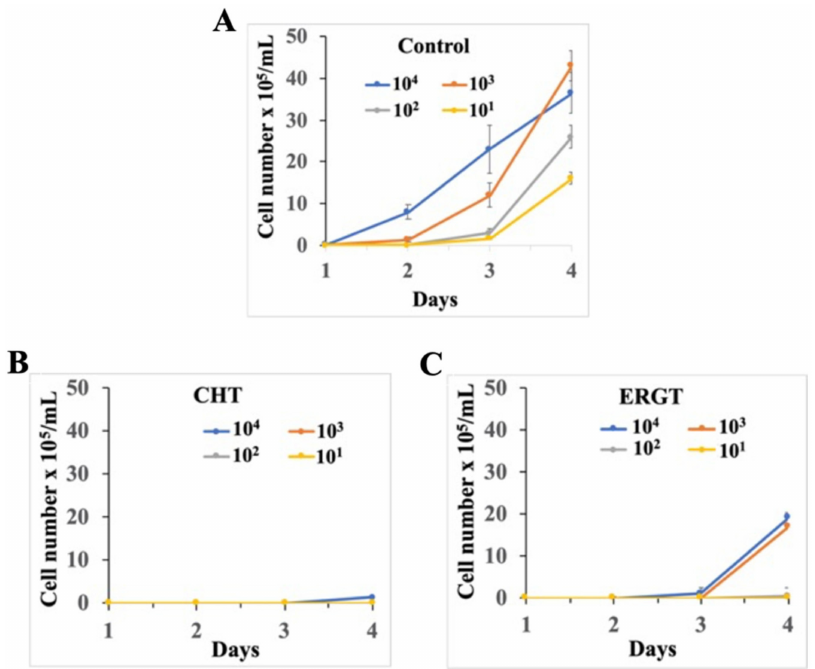
Figure 5. Extended effect of CHT and ERGT on T. brucei BF cell growth. The BF cells were pretreated with CHT and EREGT at 5 × EC 50 concentrations for 2 h. Cells were harvested, washed to remove drugs and reinoculated in fresh medium at different cell numbers (10 4 /mL, 10 3 /mL, 10 2 /mL and 10 1 /mL). The untreated control cells were run in parallel starting with different inoculum sizes. Cell number was counted each day for 4 days and plotted against time in culture. ( A ) control, ( B ) and ( C ) are CHT and ERGT treated cells, respectively. Standard errors were calculated from four independent